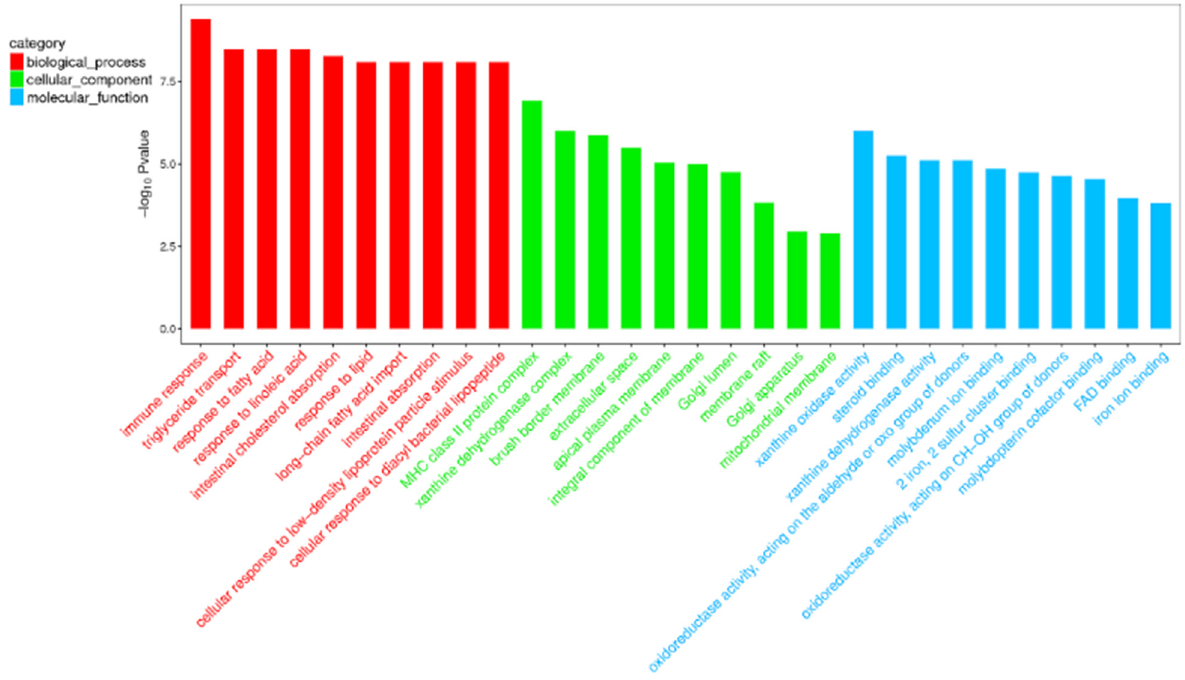
Figure 4. Top 30 categories of GO analysis. The basic information for each node, i.e., the GO ID and GO term, is displayed in the corresponding graph. The x -axis is the GO entry name and the y -axis is the log 10 p -value.